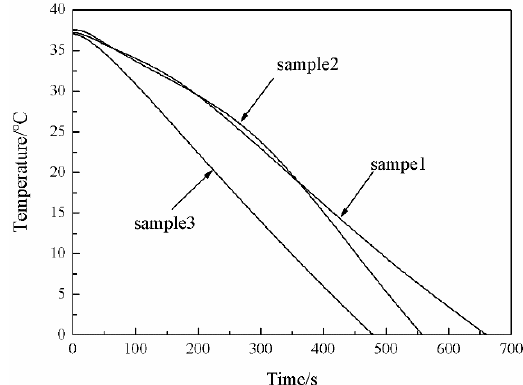
Figure 10. The low-temperature resistance: sample 1 was the MPF; sample 2 was the microPCM function layer with a coating thickness of 1.5 mm; sample 3 was the SiO 2 aerogel thermal insulation layer with a coating thickness of 1.5 mm.